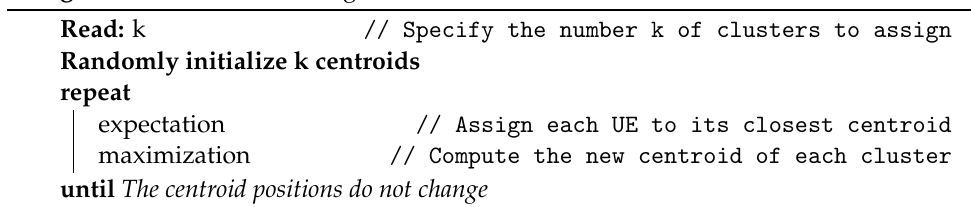
Algorithm 1: UE k-means algorithm.